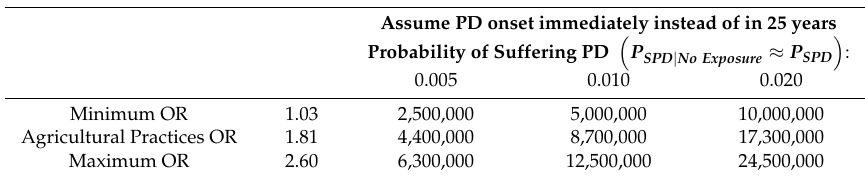
Panel D: Sensitivity Analysis 4 Assume PD onset immediately instead of in 25